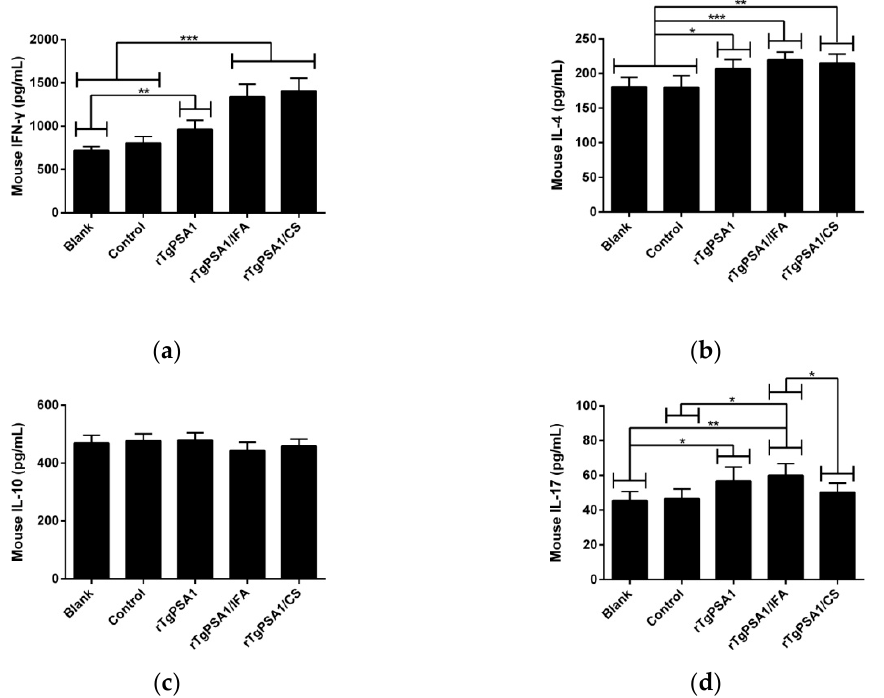
Figure 5. Cytokine secretions in mice. Commercially available ELISA kits were used to determine levels of ( a ) IFN- γ , ( b ) IL-4, ( c ) IL-10, and ( d ) IL-17 in mouse serum after the second immunization (week four). Each sample was conducted once. Results were estimated using one-way ANOVA tracked by Dunnett’s test, and values are shown as mean ± SD (n =